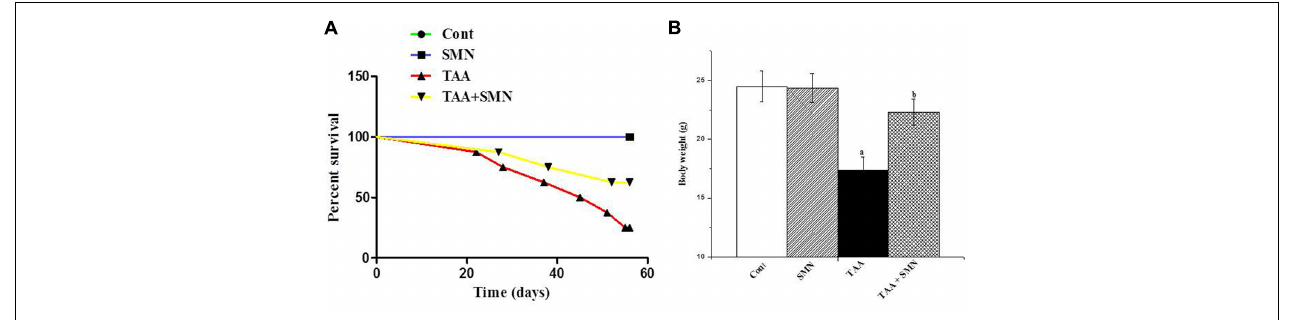
FIGURE 2 | (A) Survival curve of the animals obtained from the data of the 8 weeks study. (B) Effect of silymarin treatment on the body weight of animals of different groups.